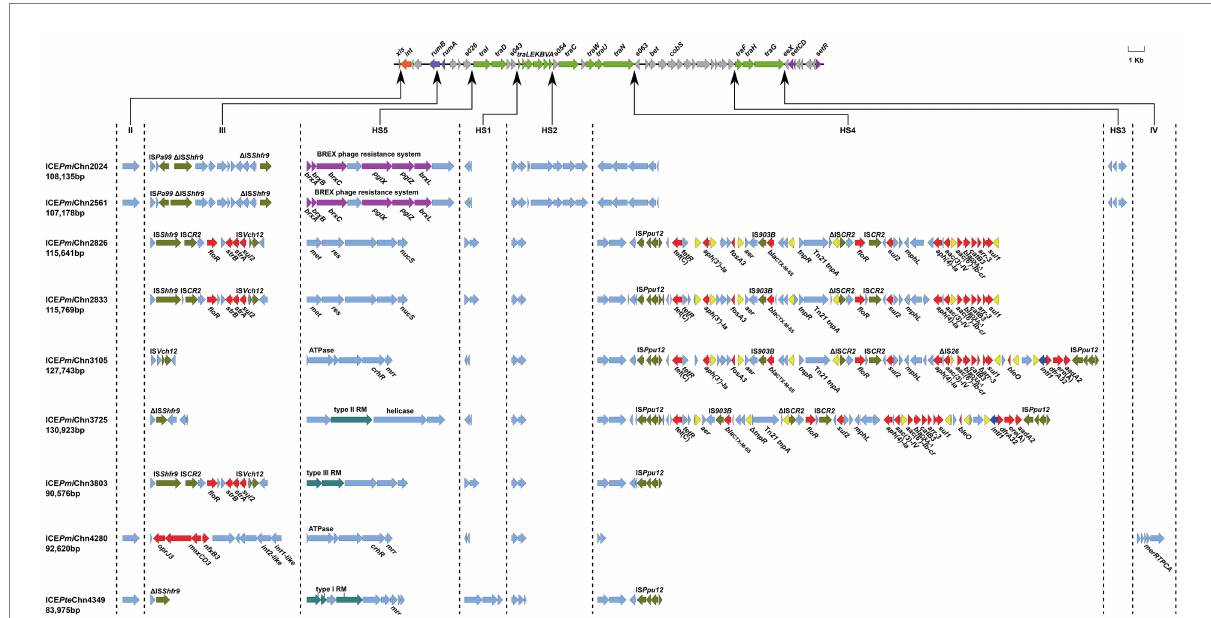
FIGURE 2 Genetic organization of the ICEs in this study. The upper line shows the backbone of SXT/R391 ICEs with conserved core genes. Arrows in orange, purple, green and amaranth indicate genes involved in site-specific excision and integration ( xis and int ), DNA repair ( rumAB ), conjugative transfer ( tra ) and regulation ( setCDR ). Other core genes are indicated by light gray arrows. Under the backbone, hotspots (HS1-HS5) and variable regions (II–IV) are shown, with thin arrows indicating the sites of their insertion. ARGs, insertion sequences, BREX phage resistance system, and restrictive modification systems are highlighted in red, olive, purple-red, and blue-green, respectively, except that IS 26 is highlighted in yellow. Other genes in the insertion regions are indicated by light blue